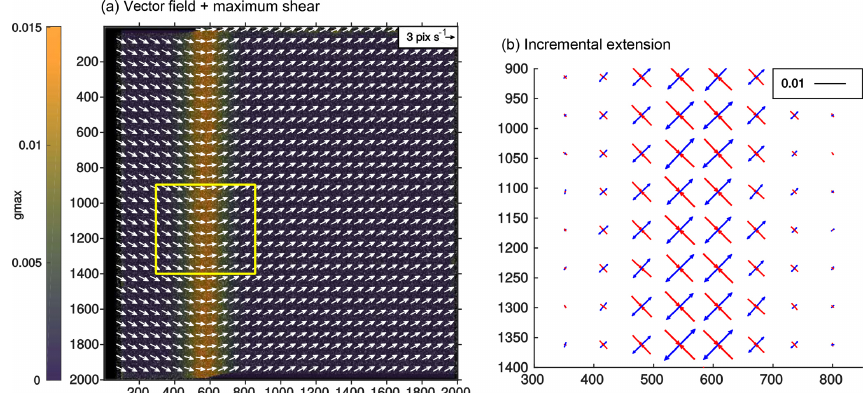
Figure 6. Incremental extensions from PIV. (a) Synthetic PIV test with vertical shear zone. Horizontal velocity is homogeneous, but vertical velocity changes sign across a vertical shear at x = 580 pixels at frame 25. The shear is illustrated with γ max , the difference between the principal strains. (b) Principal extensions e max and e min across the shear zone. Deformation ellipsoids could have been drawn as well, but the incremental deformation between successive images is very small and the incremental deformation ellipsoids would be very close to